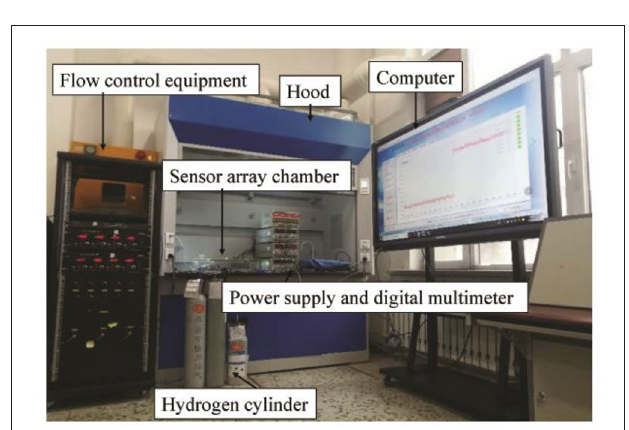
FIGURE 6 | The experimental setup of MQ-8 gas sensor